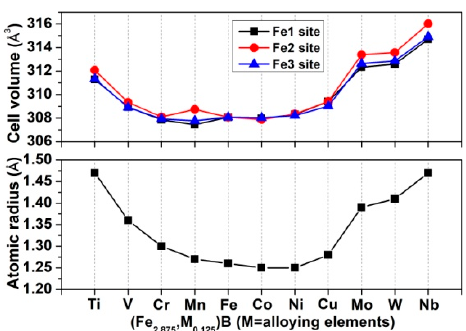
Figure 2. Cell volume of Fe 3 B and alloyed Fe 3 B and atomic radius of Fe and alloying elements.